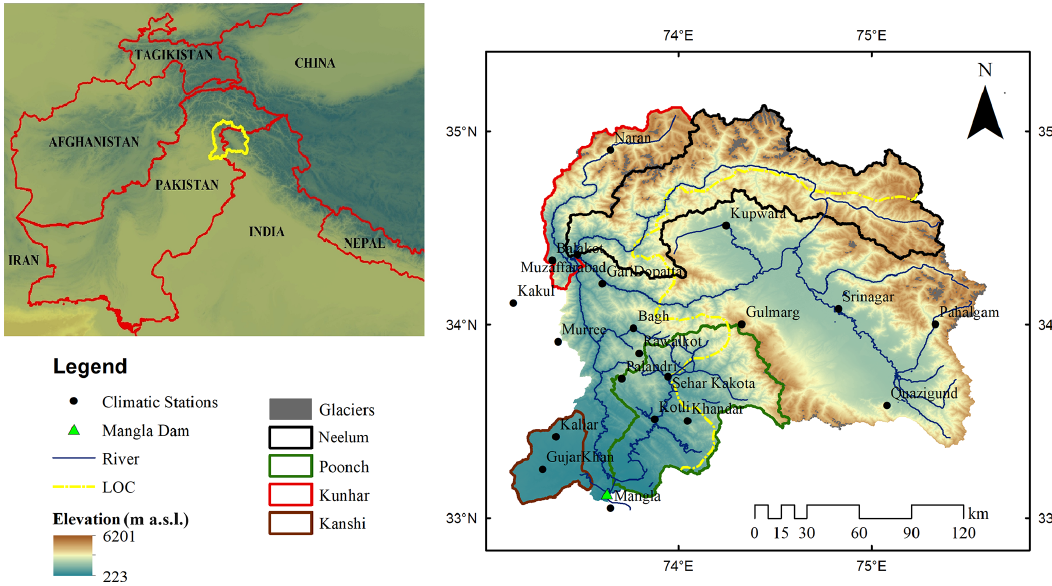
Figure 1. Location of the UJB and spatial distribution of climatic